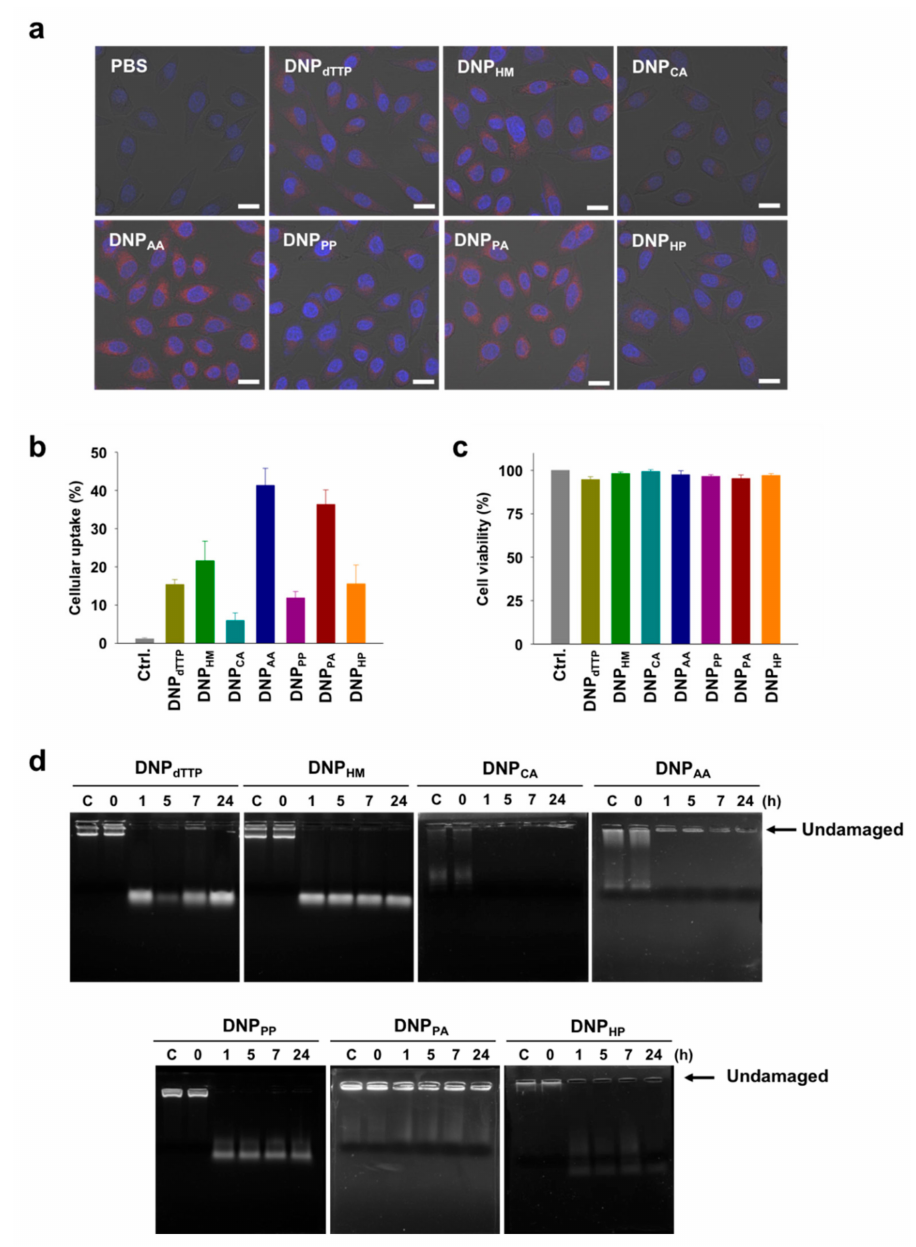
Figure 3. ( a ) Confocal fluorescence microscopic images of cells treated with Cy5-labeled DNPs (10 nM). Red: Cy5-DNPs, blue: nuclei. Scale bar: 25 µ m. ( b ) Cellular uptake efficiency of Cy5-labeled DNPs measured by flow cytometry. ( c ) Viability of cells treated with DNPs (10 nM). ( d ) Agarose gel electrophoresis of DNPs after incubation with DNase I. The arrow indicates the position of undamaged